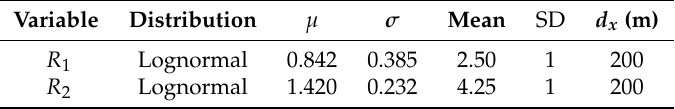
Table 1. Lognormal distribution parameters µ and σ , distribution mean and standard deviation (SD), and correlation length d x for resistance variables R 1 and R 2 .